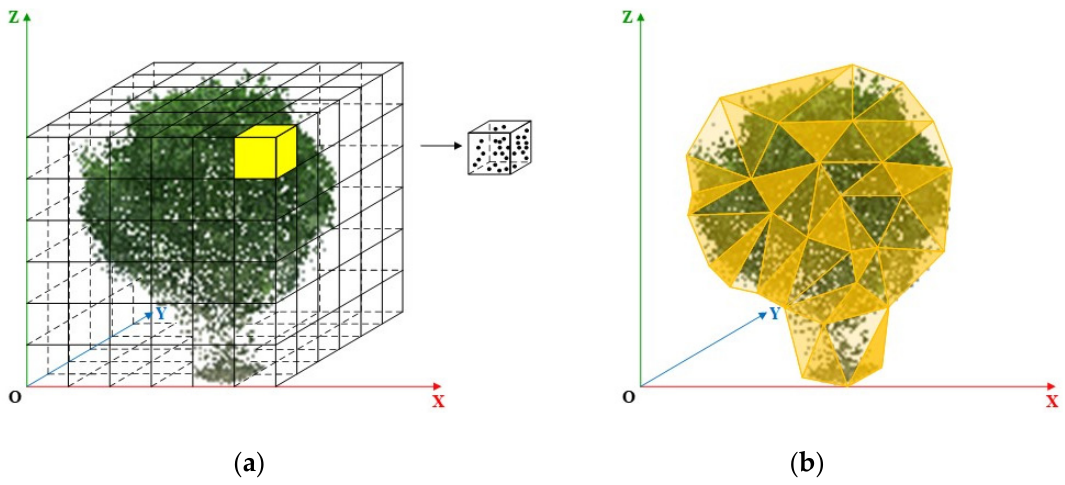
Figure 10. Schematic diagram of ( a ) voxel-based method and ( b ) 3D convex hull method.